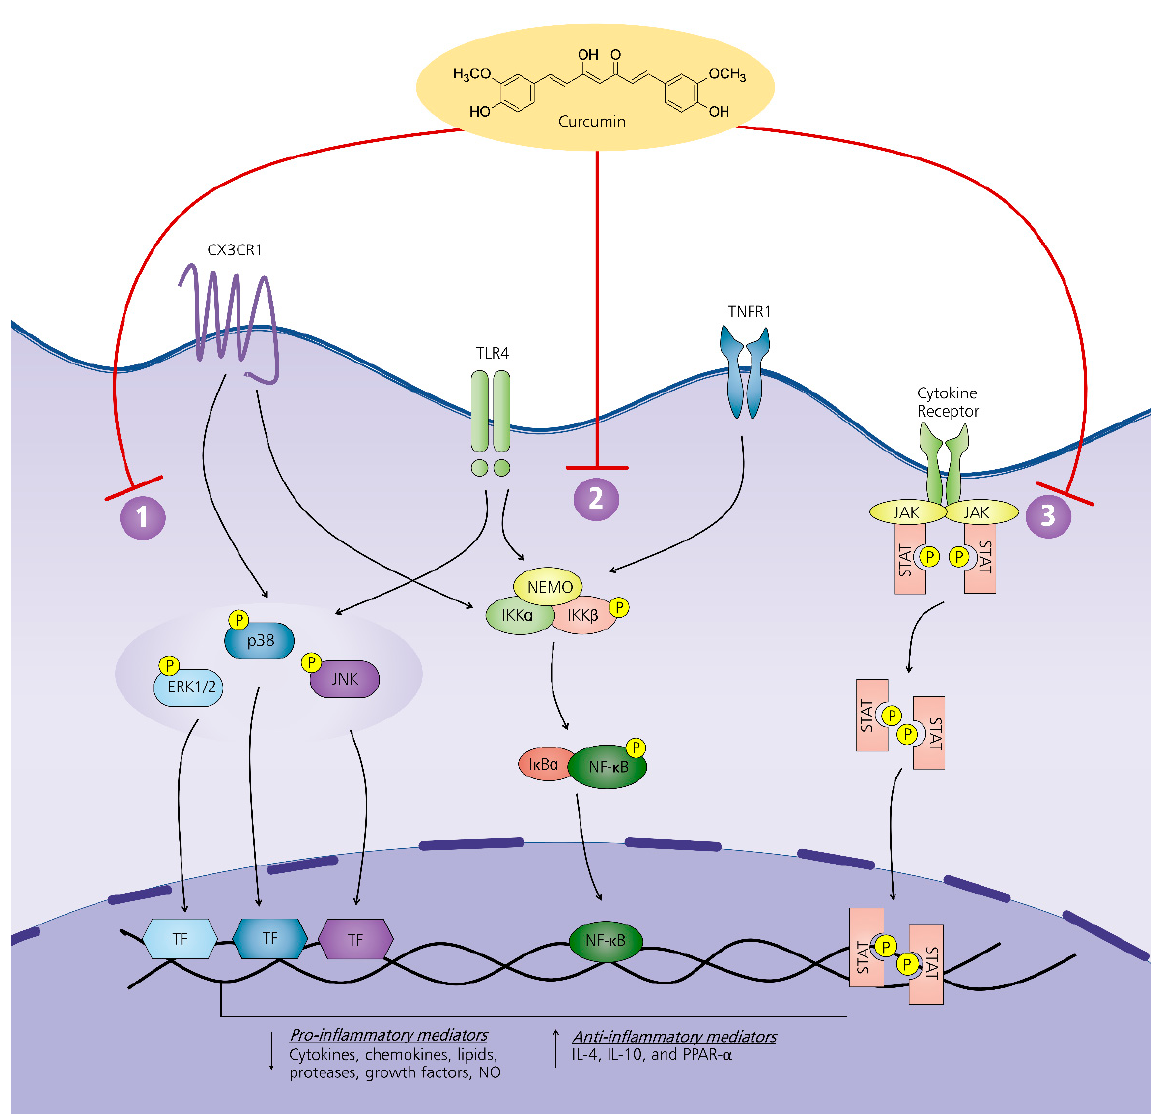
Figure 3. Proposed signaling cascades of curcumin in the spinal glia. Curcumin suppresses the activation of glial cells and inflammatory mediators via modulating the (1) MAPK, (2) NF- κβ , and (3) JAK-STAT pathways. (1) Curcumin regulates the MAPK signaling pathway by suppressing the activation of three major kinases: ERK, p38, and JNK, and at the upstream level, curcumin reduces the expression of CX3CR1 and TLR4 receptor that inhibits the activation of p38 in the MAPK pathway. (2) Curcumin inhibits the NF- κβ pathway via abrogating activation of NF- κβ . At the upstream level NF- κβ pathway, curcumin inhibits the expression of CX3CR1, TLR4, and TNF- α receptors. (3) Curcumin inhibits neuroinflammation by suppressing the phosphorylation of JAK and STAT proteins. Suppression of these pathways inhibits the release of pro-inflammatory mediators and enhances the release of anti-inflammatory mediators by spinal glia. Abbreviations: CX3CR1, CX3C chemokine receptor 1; TLR4, toll-like receptor 4; TNFR1, tumor necrosis factor receptor 1; ERK, extracellular-signal-regulated kinase, JNK, c-Jun N-terminal kinases; TF, transcription factor; NEMO, NF- κβ essential modulator, IKK, I κ B kinase; NF- κβ , nuclear factor κ light-chain-enhancer of activated B cells; JAK, Janus kinase; STAT, signal transducer and activator of transcription protein; NO, nitrite oxide; IL, interleukin, PPAR- α , peroxisome proliferator-activated receptor- α .